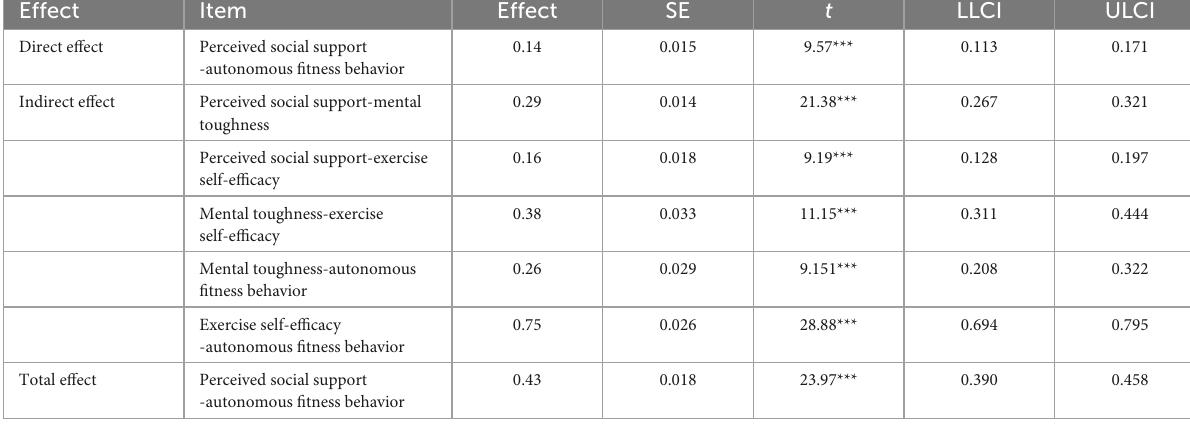
TABLE 3 Regression analysis of the relationship between variables.